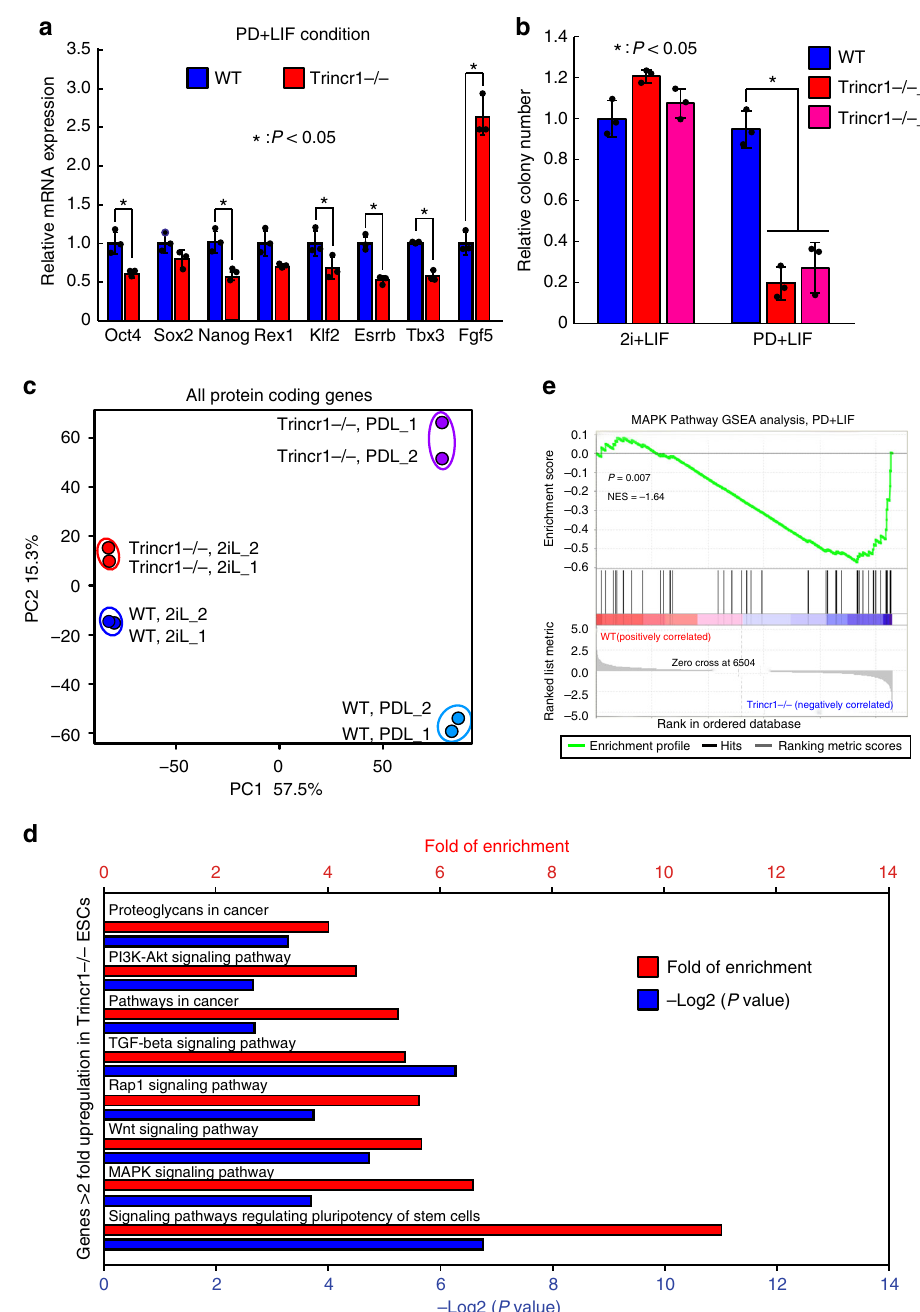
Fig. 3 Trincr1 promotes ESC self-renewal and suppresses ERK target genes. a RT-qPCR analysis of pluripotency genes and Fgf5 in Trincr1 − / − ESCs in PD + LIF condition. The β -actin gene was used as a control. For each gene, data were normalized to the mRNA level of wild-type ESCs. n = 3 biological replicates. b Colony formation assay for wild type, Trincr1 − / − ESCs cultured in 2i + LIF or PD + LIF condition on feeder cells in a 12-well plate. Two independent Trincr1 − / − ESC clones were analyzed. Data were normalized to the colony number of wild-type ESCs in 2i + LIF. n = 3 biological replicates. c Principal component analysis of all protein-coding genes in wild type and Trincr1 − / − ESCs in 2i + LIF and PD + LIF. d KEGG pathway analysis of upregulated genes in Trincr1 − / − ESCs in PD + LIF. Top 8 enriched pathways are shown with P values and fold of enrichment. e GSEA analysis for MAPK/ERK targets in wild type and Trincr1 − / − ESCs in PD + LIF. The distinct peak at the end of the ranked list indicates that MAPK/ERK target genes are generally upregulated in Trincr1 − / − ESCs. Shown are mean ± SD. For a , P values were determined by unpaired two-sided Student ’ s t -test. For b , P values were determined by unpaired two-way ANOVA with two-sided Dunnett ’ s test. For e , P value was determined by an empirical gene set-based permutation